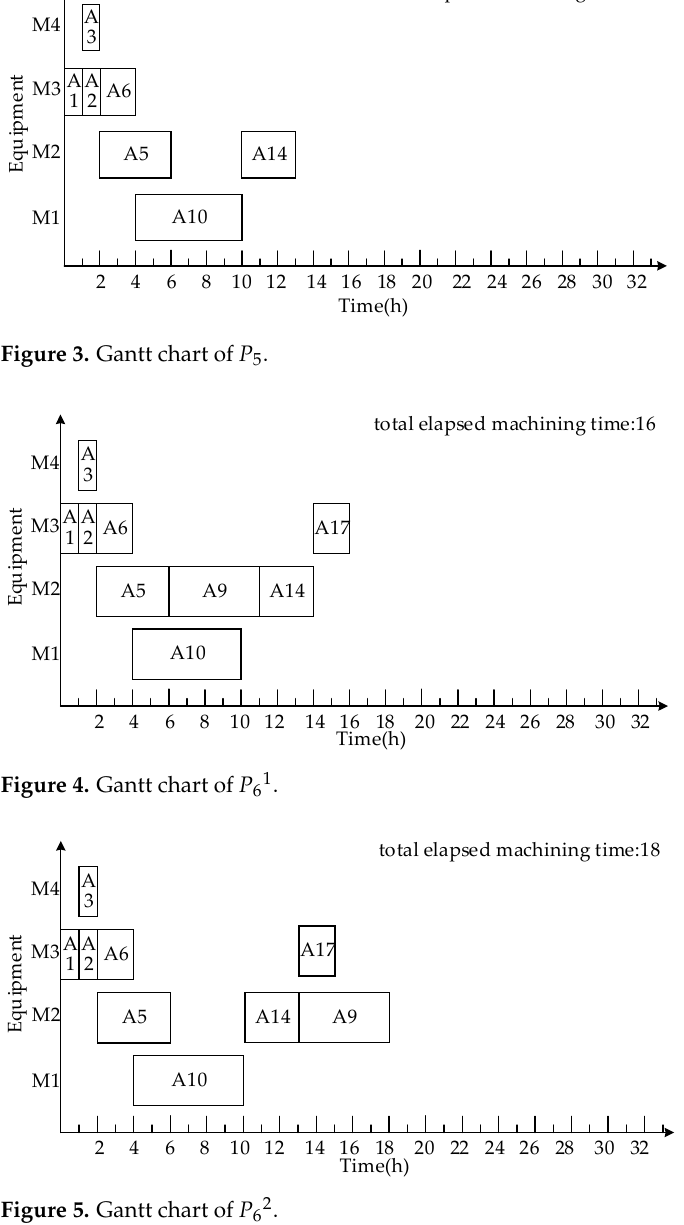
Figure 6. Gantt chart of scheduling A using the ROHISA. 2.